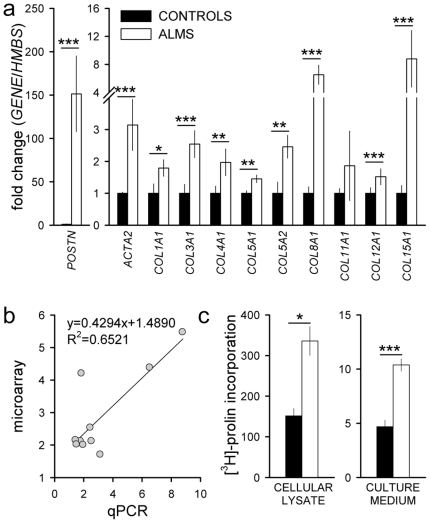
Increased mRNA expression and deposition of ECM components in ALMS fibroblasts.(a) POSTN, ACTA2, COL1A1, COL3A1, COL4A1, COL5A1, COL5A2, COL8A1, COL11A1, COL12A1, COL15A1 transcripts were quantified by qPCR and normalized to HMBS mRNA content in control (CONTROLS) and ALMS fibroblasts (ALMS). Results are reported as mean values ± SEM and are expressed as fold change with respect to controls, arbitrarily set as 1 for each of analyzed transcript. *P<0.05, ** P<0.01, *** P<0.001 ALMS fibroblasts versus controls (see also Figure S6). (b) The fold change observed between ALMS and control fibroblasts in microarray analysis was plotted against the fold change measured by qPCR for ACTA2 and COLs transcript. A strong correlation between the two methods was observed. Pearson coefficient = 0.8. (c) Fibroblast collagen protein synthesis and release were determined by [3H]-proline incorporation, and expressed as counts per minute normalized to DNA content. *P<0.05, ***P<0.001 ALMS fibroblasts versus controls. Black bars correspond to control and white bars to ALMS fibroblasts.